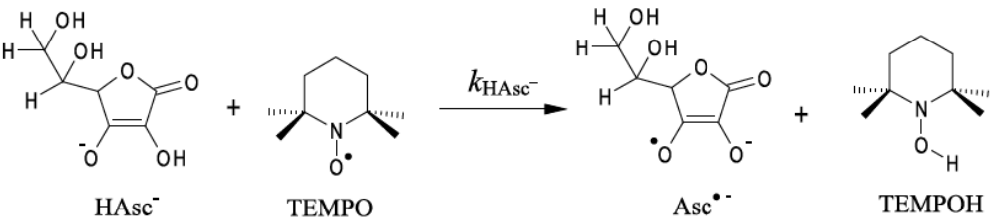
Table 1. Kinetic isotope effects, activation parameters Δ H ‡ and Δ S ‡ , isotopic differences ΔΔ H ‡ (D,H) and ΔΔ S ‡ (D,H) and ratios A H / A D in the reaction of ascorbate with TEMPO radical. Adapted from [17] and